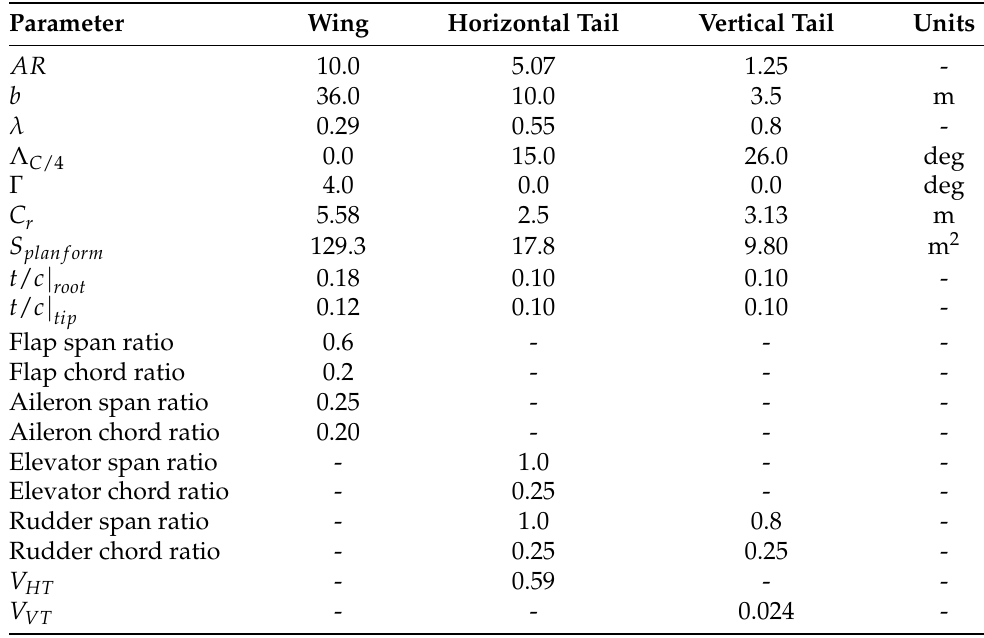
Table 8. Geometric properties of the SE 2 A SR